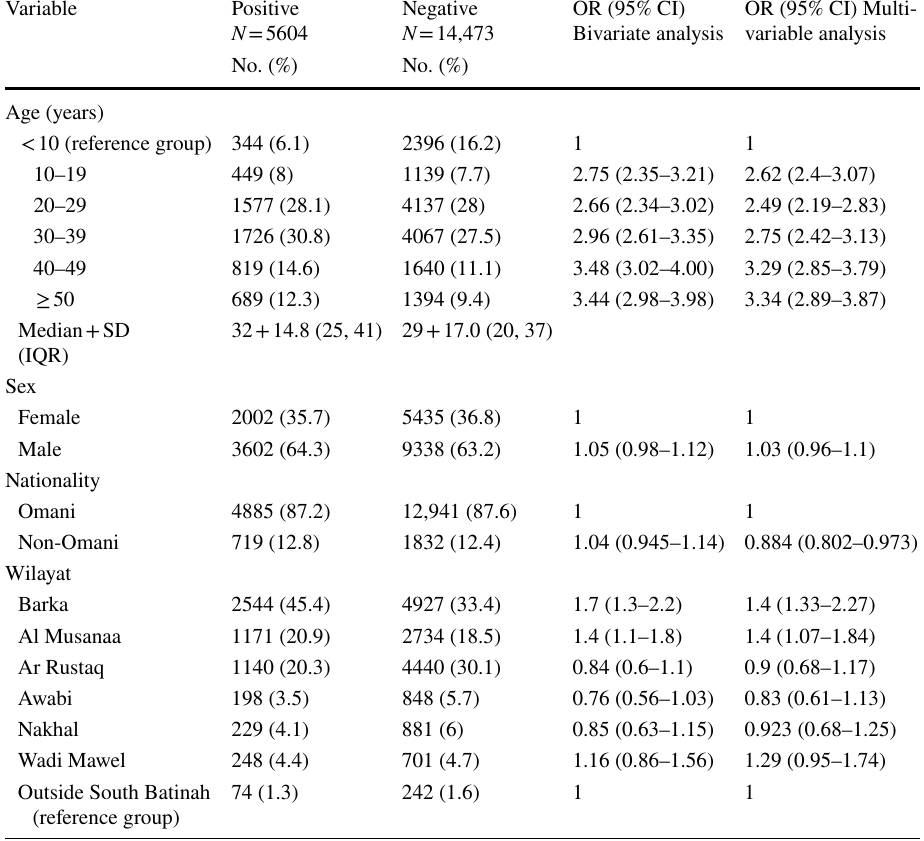
nationality of people tested for SARS-CoV-2 in South